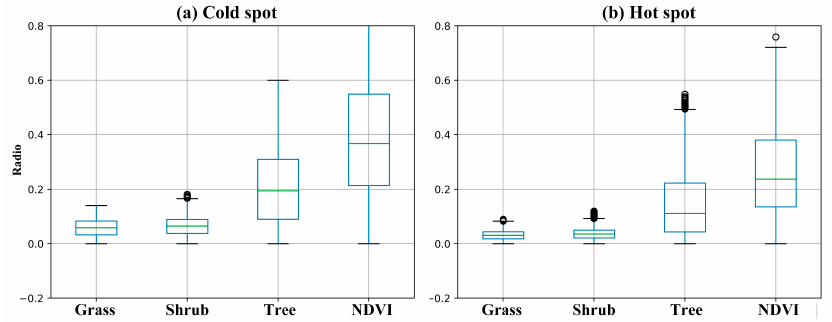
Figure 6. Boxplots depicting the statistical information of the GST and NDVI results at ( a ) cold and ( b ) hot spots.